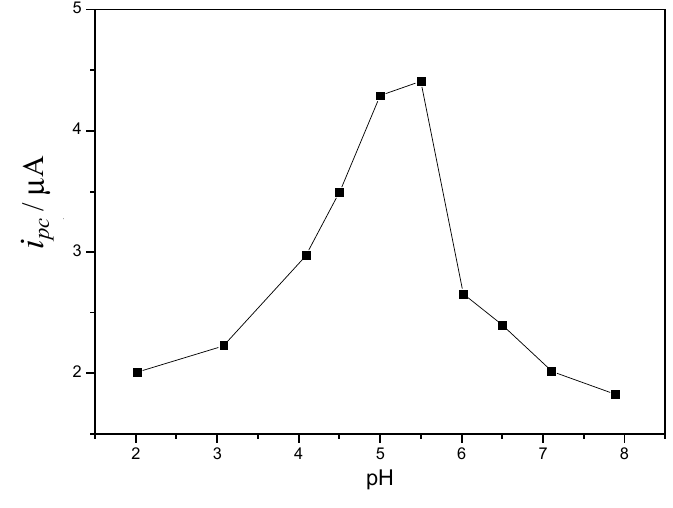
Figure 5. The effect of pH on i